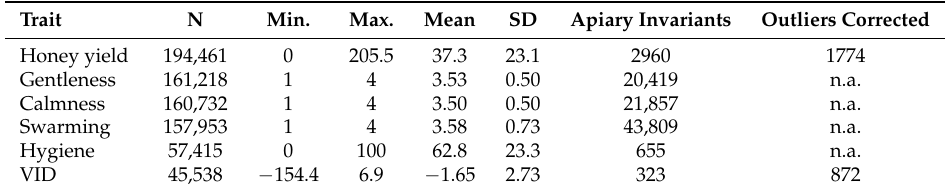
Table 5. Descriptive statistics for honey yield, defensive behavior, swarming behavior and Varroa resistance traits.